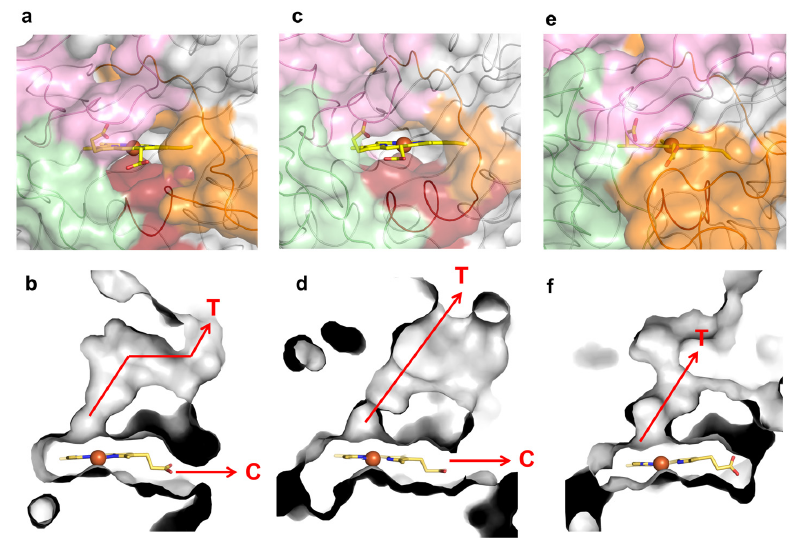
Figure 5. Loops, molecular tunnels and cavities in class P K. pneumoniae DyP (PDB 6FKS) ( a , b ), class I B. subtilis Bs DyP (PDB 7PKX) ( c , d ) and class V A. auricula-judae DyP (PDB 4AU9) ( e , f ). The regions lining the cavities are colored in light pink (loop 1), green (loop 2), dark red (small α -helix) and orange (loop 3). The tunnels (T) and cavities (C) corresponding to panels ( a , c , e ) are represented as grey ASA in panels ( b , d , f ), respectively.